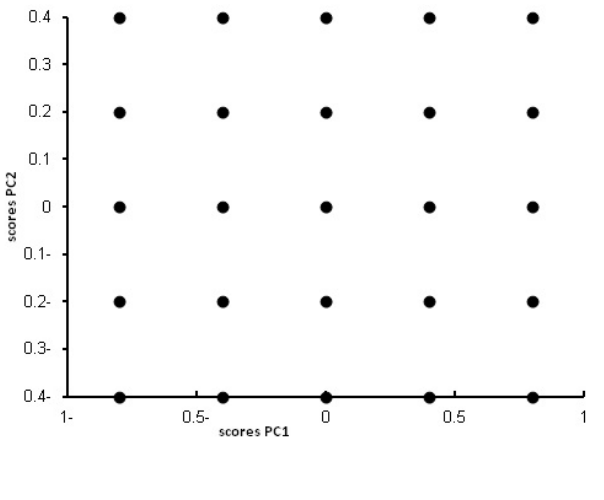
Figure 7. Scores plot for the mean centered 25 samples concentration matrix of the five level two component experimental